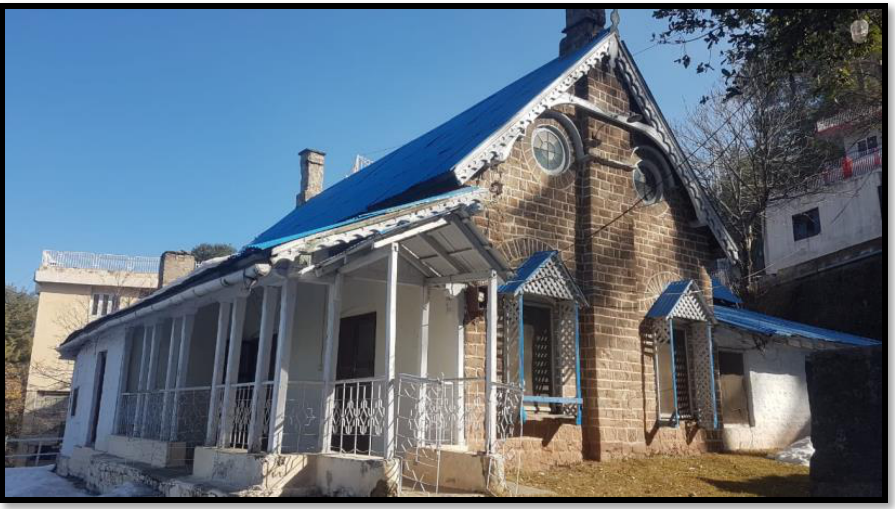
Figure 3. Photograph of the case study building (Stone finished, single-story with pitched roof) .